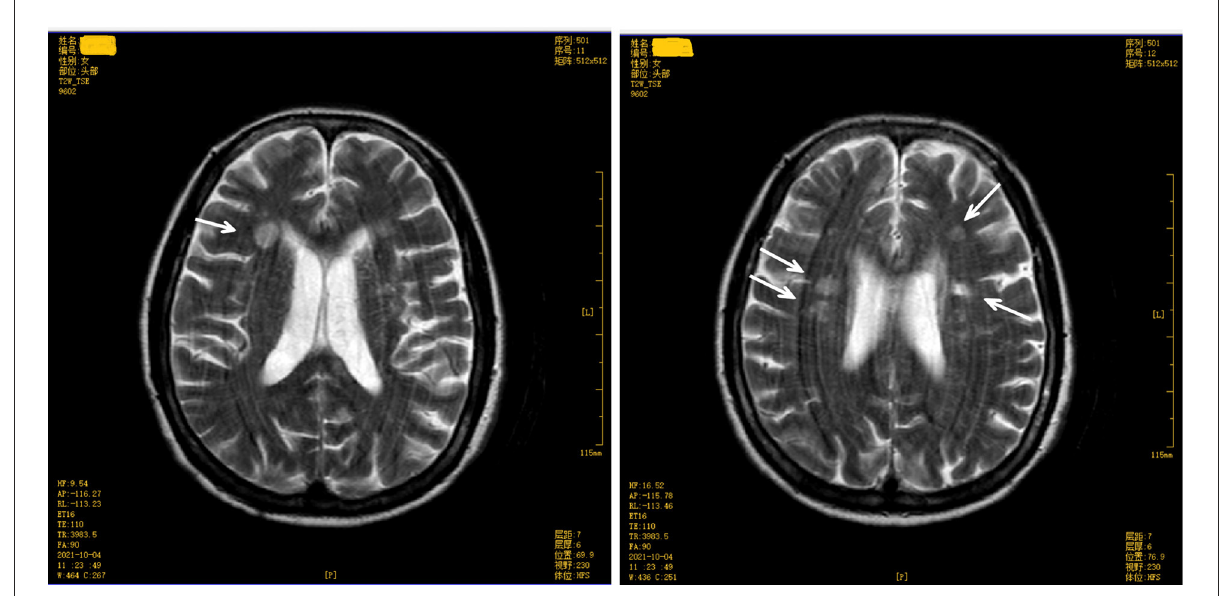
FIGURE3 Brain magnetic resonance imaging (upper level of lateral ventricle) T2 weighted image shows multiple abnormal oval-shaped hyperintense signal lesions in the cerebral hemisphere and